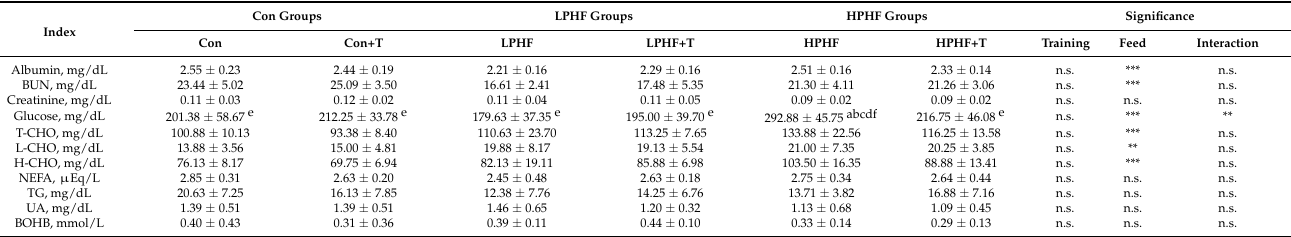
Table 3. Effects of LPHF, HPHF and/or training on plasma biochemical